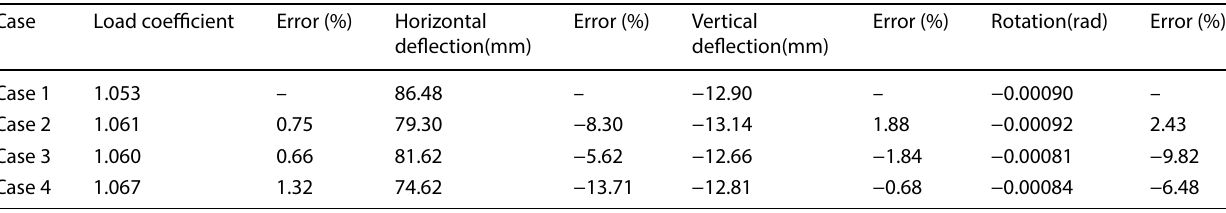
Table 4 Deflection at limit load at point A for nine-story frame